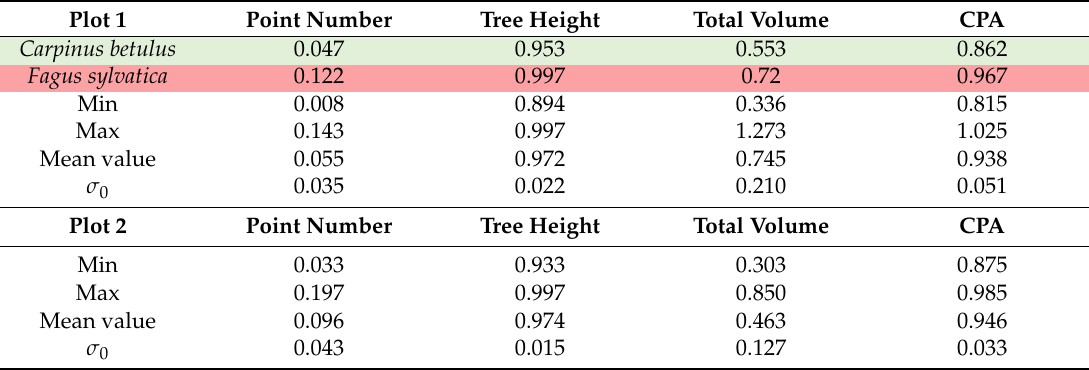
Table 4. Summary of the proportion x MLS /x TLS of the parameters derived from the QSM of 24 trees of plot 1 and 22 trees of plot 2 determined with TLS and MLS. The two trees from Figure 6 are marked with a green ( Carpinus betulus ) and red ( Fagus sylvatica )